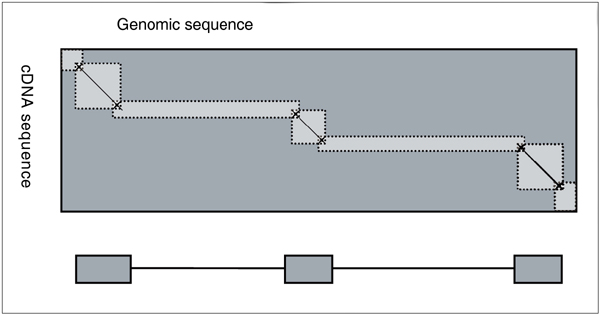
Generating the search subspace given three high-scoring segment pairs (HSPs) in the Stepping Stone algorithm. The three diagonal lines represent the three HSPs. The stars represent alignment pins. The lighter blue areas represent the search subspaces that are actually used in the heuristic method. The optimal algorithm uses the entire rectangle in blue. The block diagram shows the optimal spliced alignment where blue boxes represent an exon and the thin lines represent an intron.